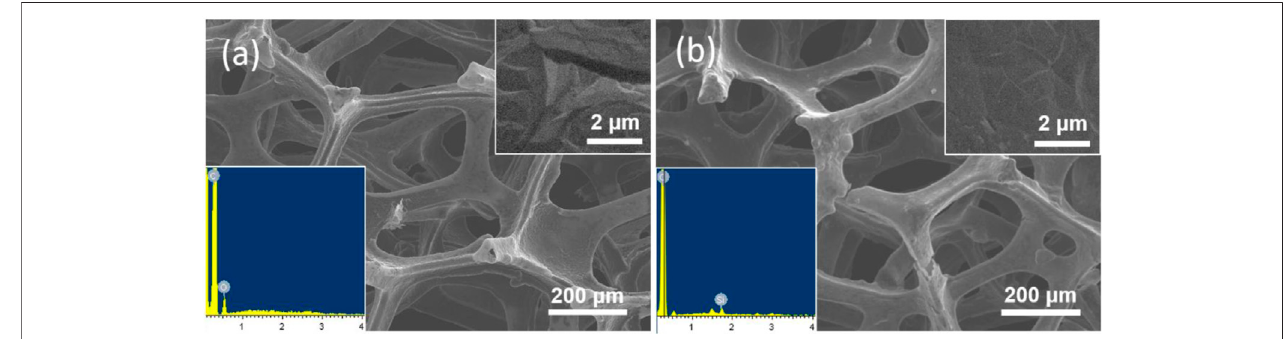
FIGURE 2 | SEM images of (A) bare 3DG and (B) VMSF/APTES/3DG at different magni fi cations. Inset in (a) and (b) is the corresponding energy dispersive spectrometer (EDS) spectrum.